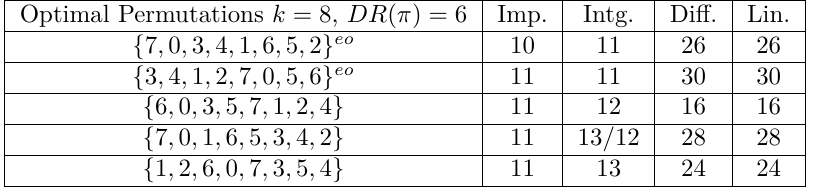
Table 11: Optimal permutations for k = 8 up to extended pair-equivalence Optimal Permutations k = 8, DR ( π ) = 6 Imp. Intg. Diff.